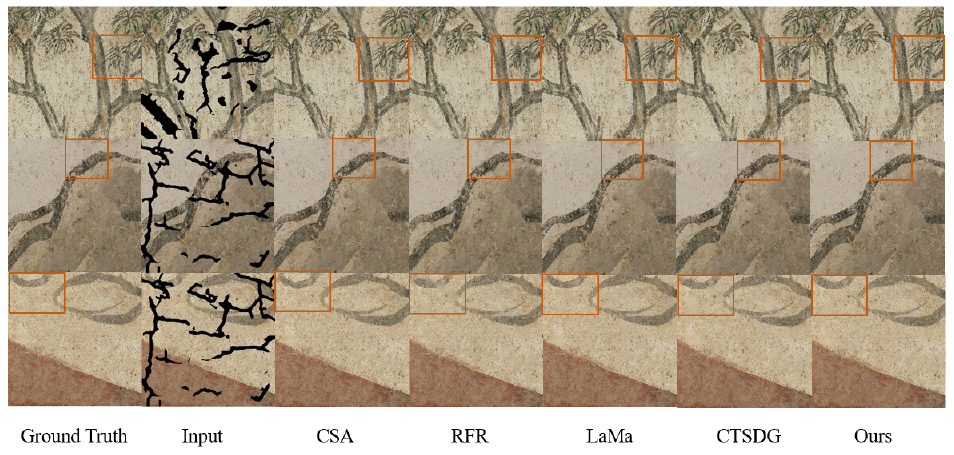
Figure 15. Comparison of inpainting results for each model on the crack masks. Our model works best and looks more similar to the original after the